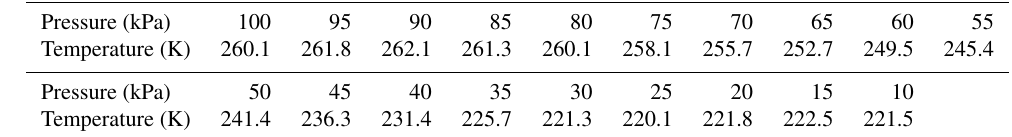
Table B4. Annual Arctic temperature data from Fig. 1 of Cronin and Jansen (2016).